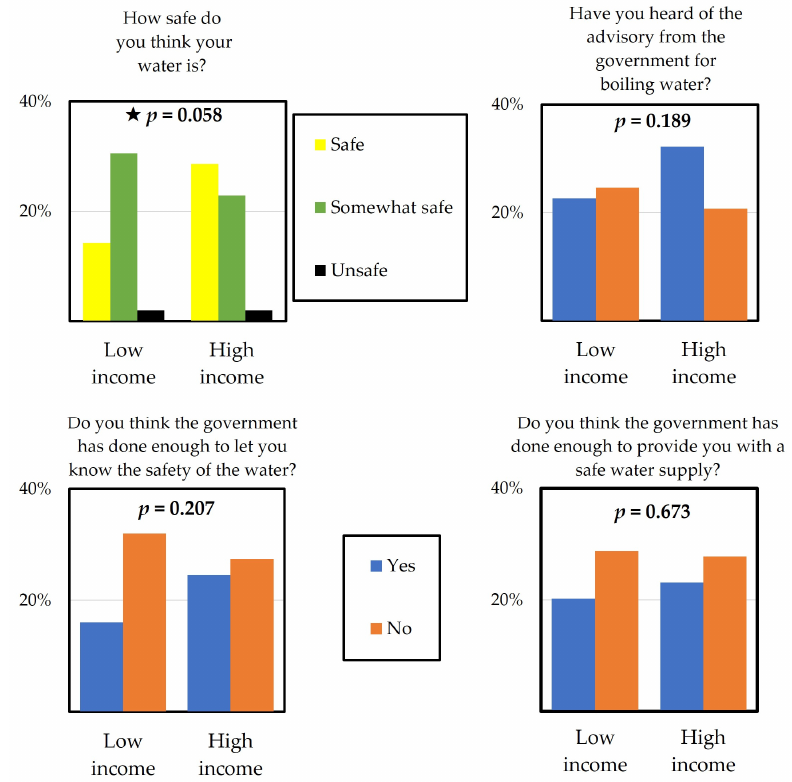
Figure 2. Survey responses to questions of perceived water quality and government role, grouped by income level (low and high). The statistical comparison of responses by the two income groups (cid:70) p is indicated for each survey question. The -value indicates statistical significance defined in this